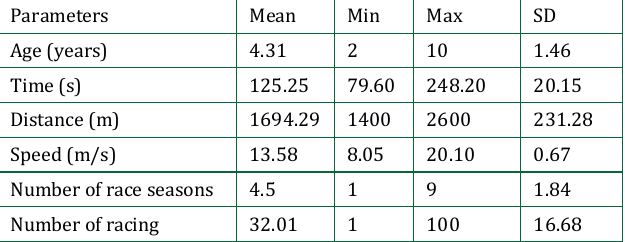
Table 2: Characteristics of Tunisian thoroughbred horses